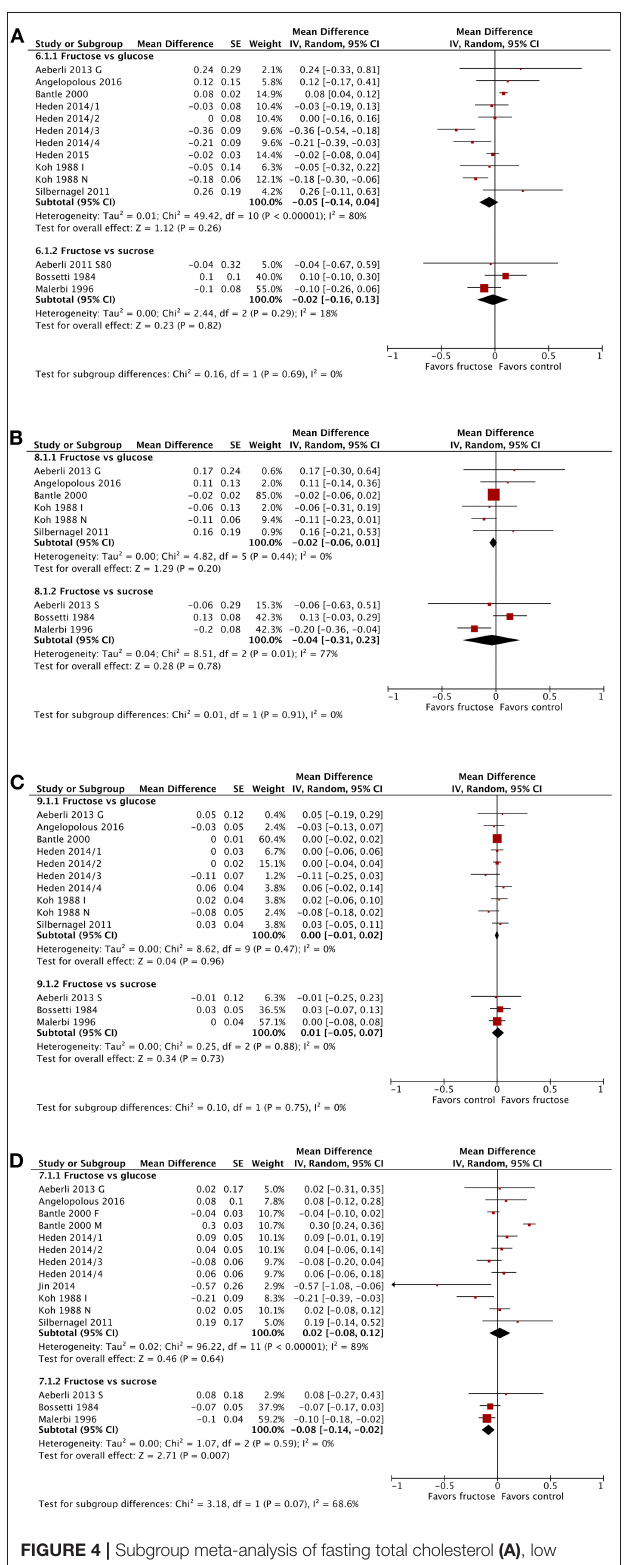
FIGURE 4 | Subgroup meta-analysis of fasting total cholesterol (A) , low density lipoprotein (B) , high density lipoprotein (C) , and triglycerides (D)